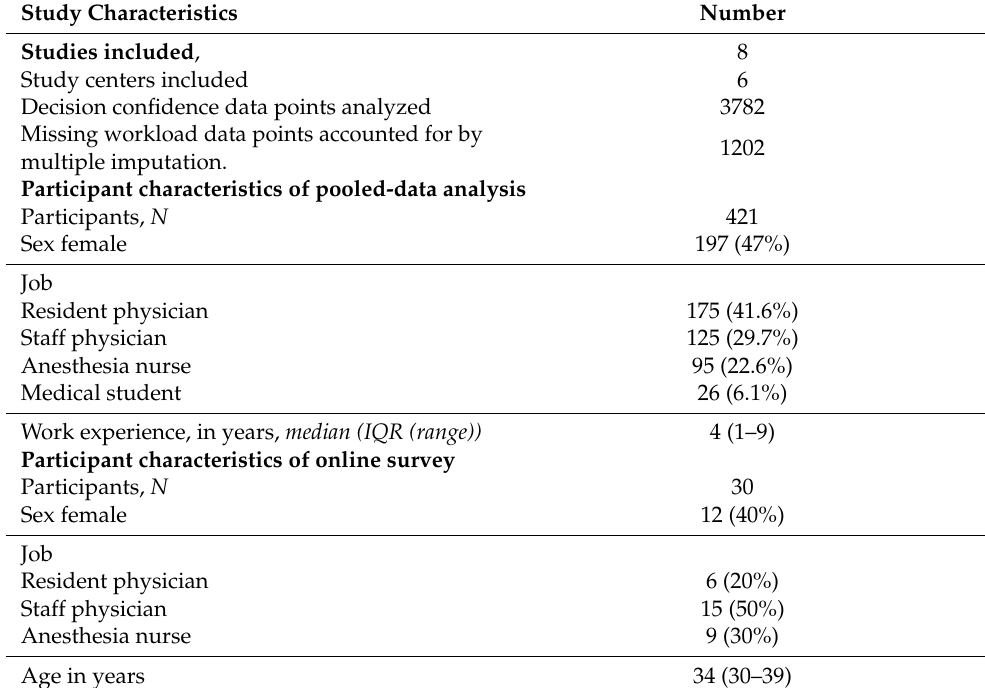
Table 2. Study and participant characteristics. Data presented as numbers (%) or median (IQR (range)). Study